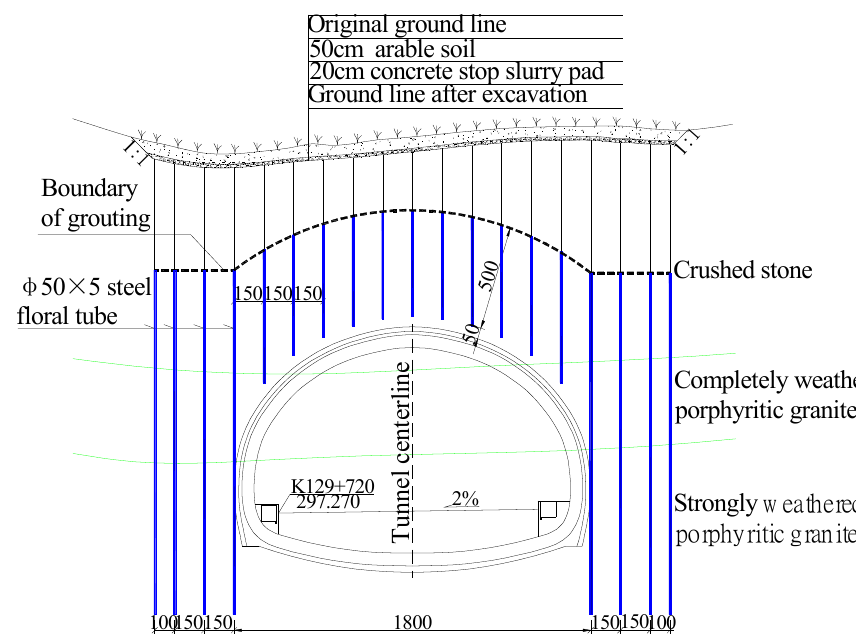
Figure 4. Elevation of surface grouting in section k129 + 720 (unit: cm).